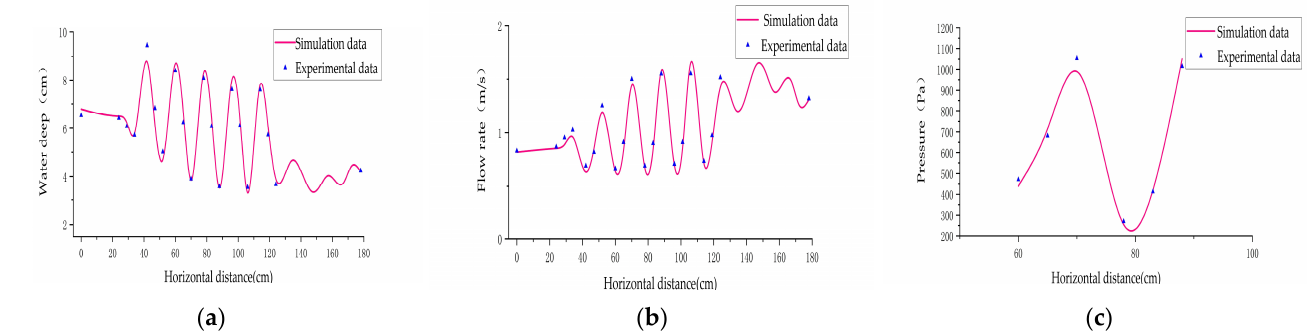
Figure 6. Comparison of simulated and measured values of Q = 30 m 3 /h. ( a ) Water depth along the course, ( b ) flow rate, and ( c ) pressure.